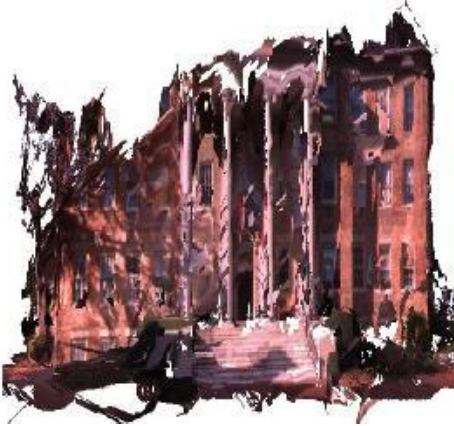
Fig.7- 3D reconstruction from Video only with the back pack